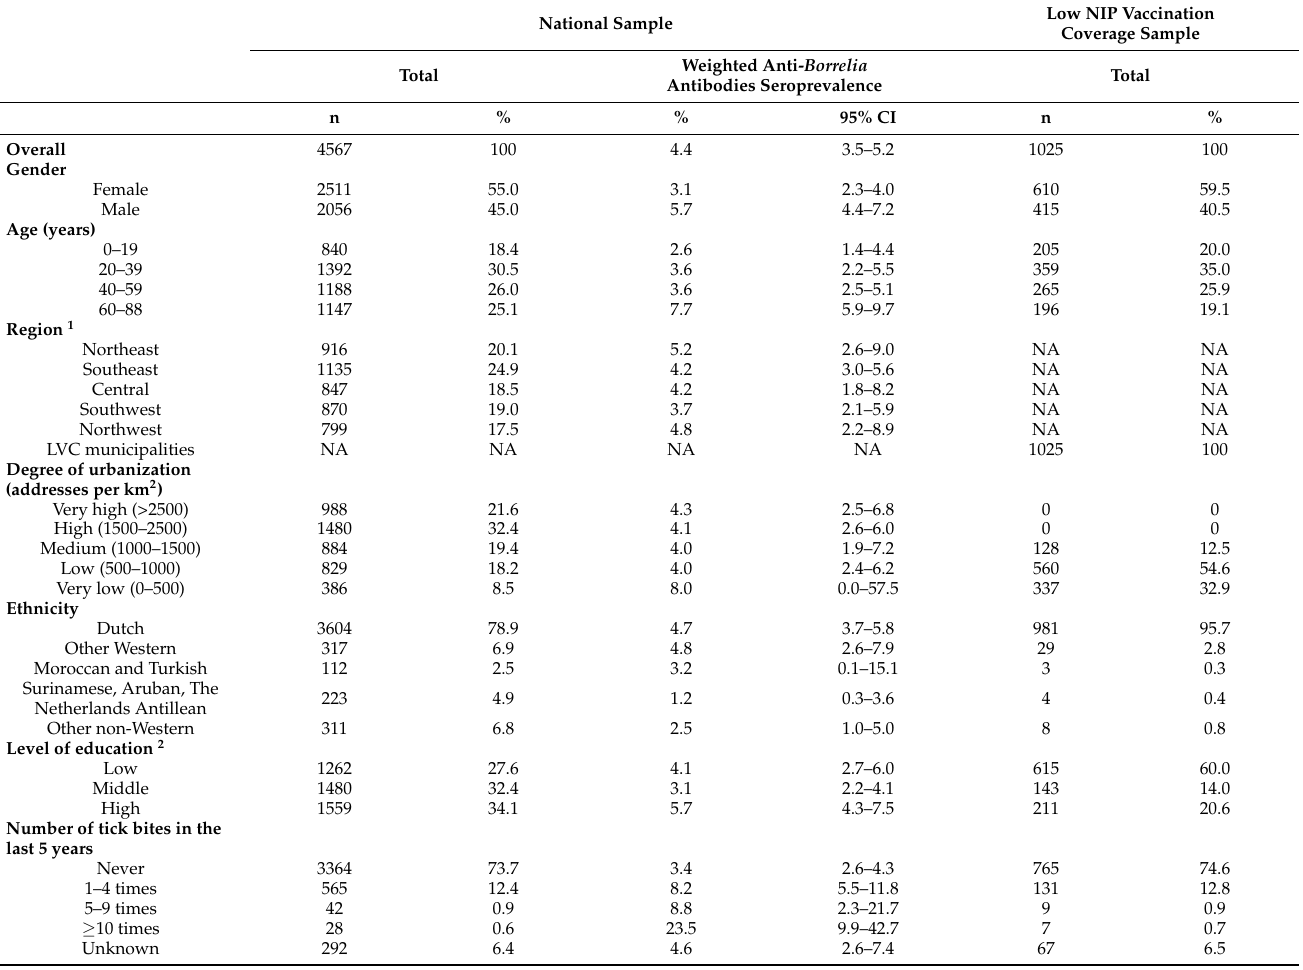
Table 1. Sociodemographic characteristics of the participants and weighed seroprevalence of anti- B. burgdorferi sensu lato antibodies in the general population of The